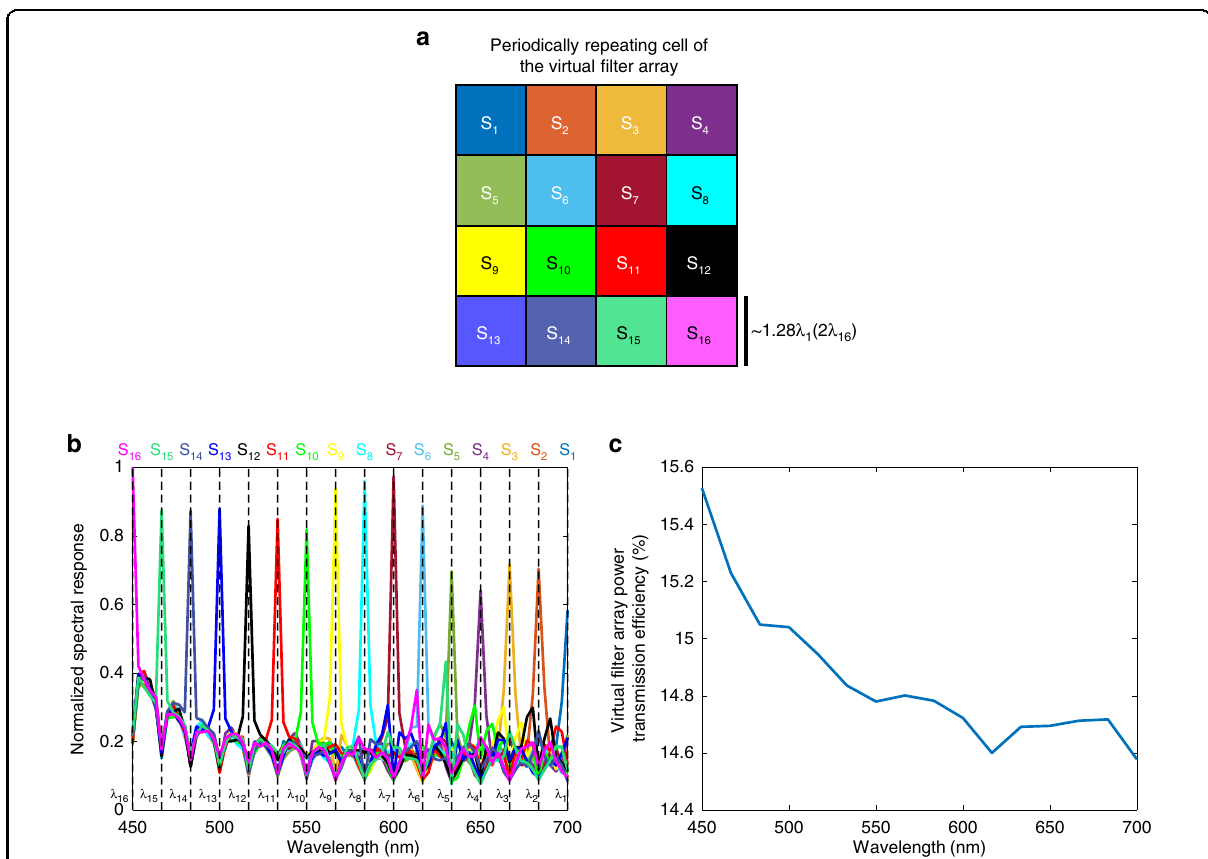
Fig. 5 Spectral responsivity and power ef fi ciency achieved by the diffractive multispectral imager shown in Fig. 4 ð N B ¼ 16 Þ . a The virtual spectral fi lter array periodically repeats at the output fi eld of view of the diffractive network. The colored labels, S i , i ¼ 1 ; 2 ; 3 ; ¼ ; 16, denote the virtual pixels assigned to the wavelength λ i . b Average normalized spectral response of the virtual fi lter array. c The wavelength-dependent transmission power ef fi ciency of the virtual fi lter array created by the diffractive optical